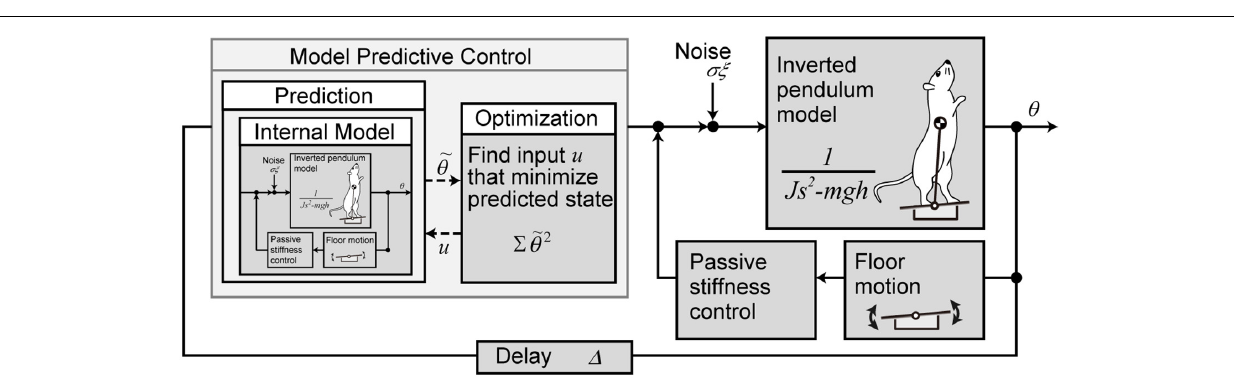
FIGURE 2 | Mathematical model of the postural motion of a rat with the prediction for tilting disturbance. The body is modeled with a single link inverted pendulum, and the control system is modeled with model predictive